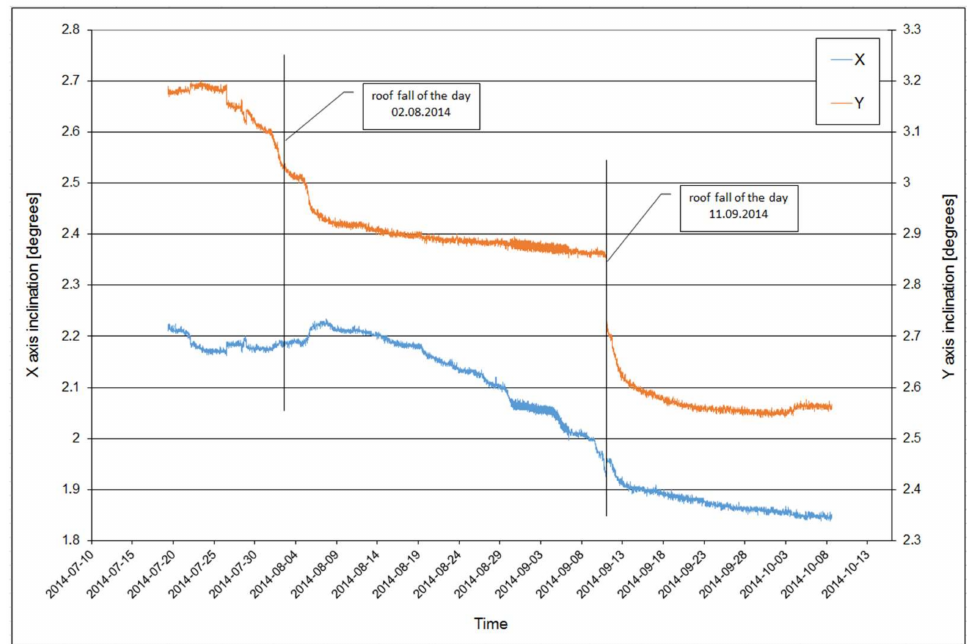
Figure 22. Changes in the inclination (X and Y components) recorded at station 1.2 located in the